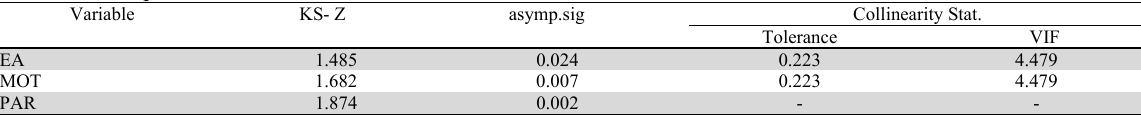
Classical Assumption Test Result